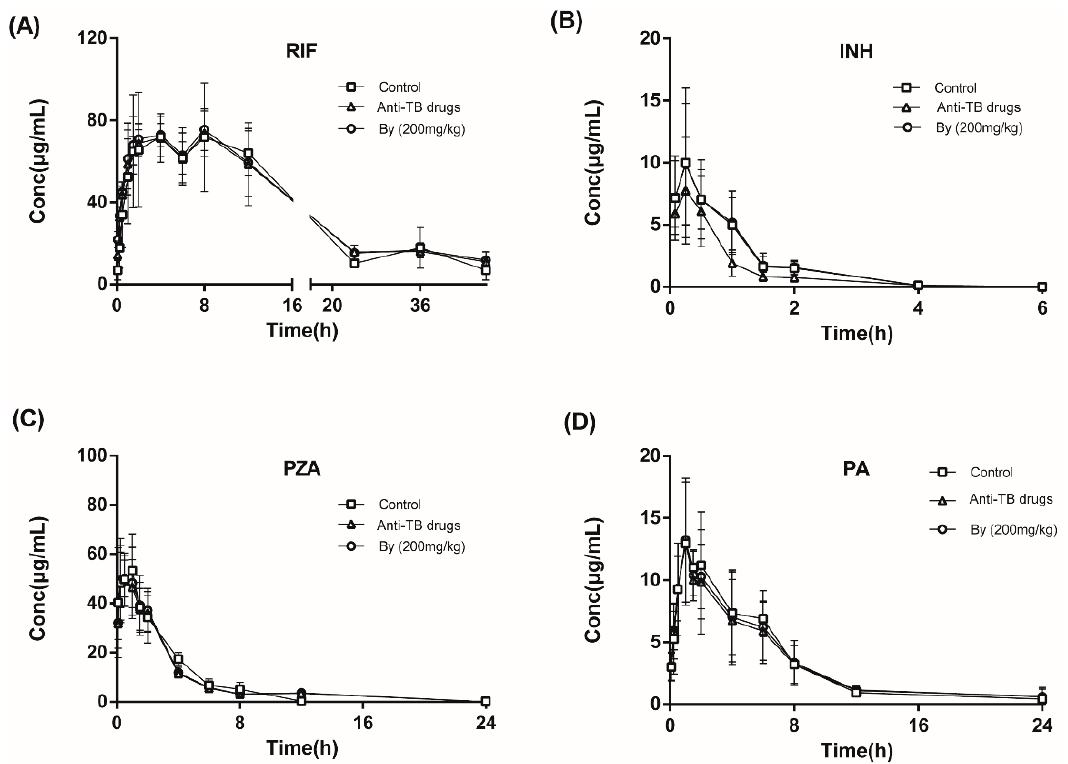
Figure 10. Mean plasma concentration-time curves of RIF ( A ), INH ( B ), PZA ( C ), and PA ( D ) in the control, anti-TB drug-intoxicated, and bicyclol (200 mg/kg) treated rats.